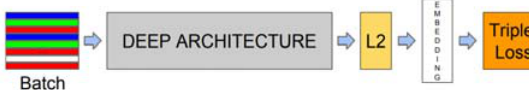
Figure 2. Model architecture of FaceNet.